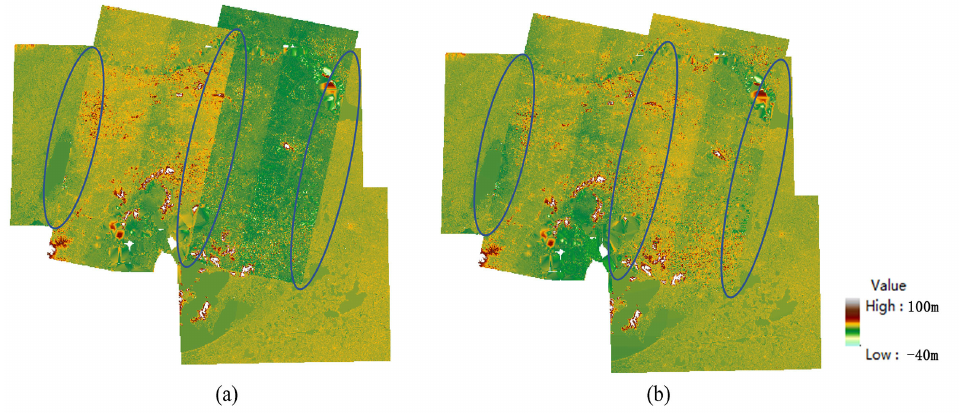
Figure 9. DSM comparison before and after the block adjustment for the ALOS and ZY-3 DSMs with the ellipses indicating the areas of significant difference. ( a ) Before block adjustment, and ( b ) after block adjustment.